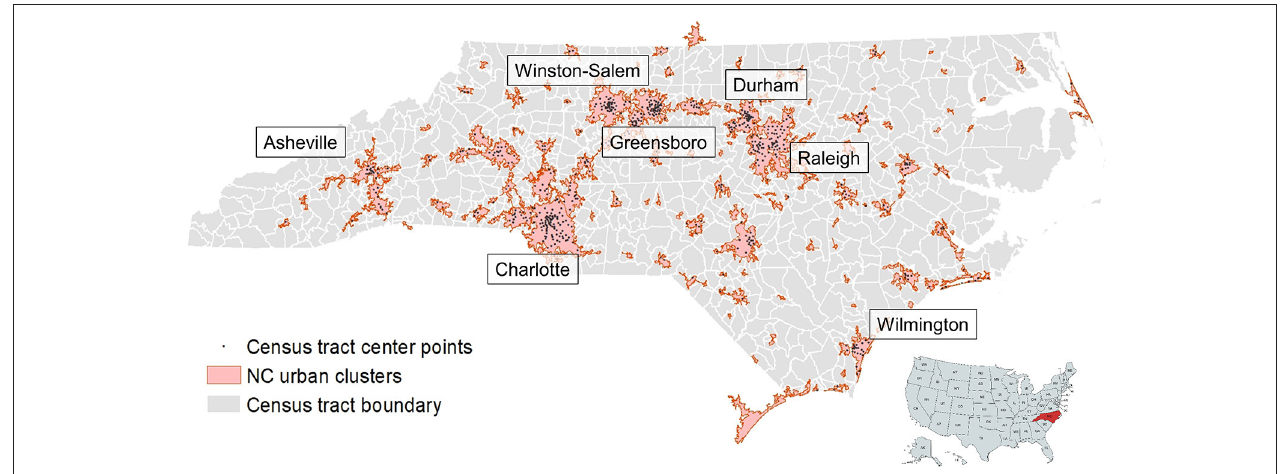
FIGURE 3 | Map of North Carolina (NC), USA, depicting park “points of interest” (POI) data used to geo-track park visits across urban clusters in the state in July 2019 and July 2020.